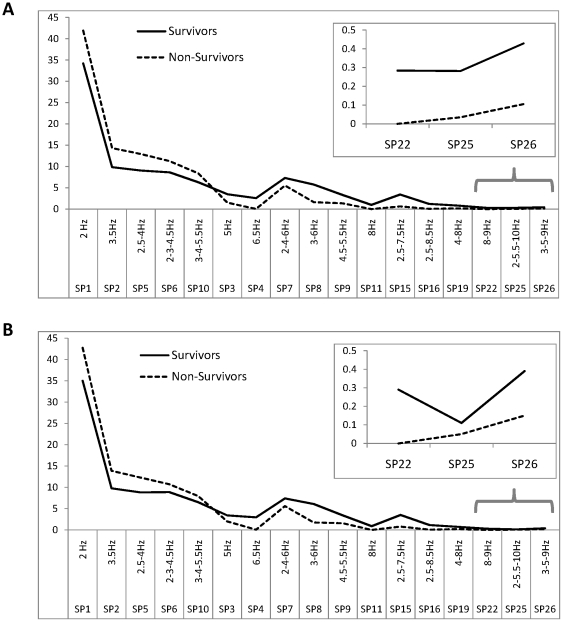
Probability-classification profiles (PCPs) for
Survivors and Non-Survivors. The X-axis displays the labels of spectral pattern (SP) types and their main frequency peaks (Hz). The Y-axis displays the share of the corresponding SPs in the percentage from the total number of the classified SPs. A line graphic was chosen instead of a bar for ease of comparison. (Note that X-axis consists of discrete values, all the in-between values are meaningless). (A) Complete groups (medicated + unmedicated) of patients. Data averaged across 171 (for Survivors) and 53 (for Non-Survivors) one-minute EEG signals and across 19 EEG channels. (B) Sub-groups of only unmedicated patients. Data averaged across 124 (for Survivors) and 33 (for Non-Survivors) one-minute EEG signals and across 19 EEG channels. Survivors – patients who survived 6 months after brain injury; Non-Survivors – patients who died 6 months after brain injury.